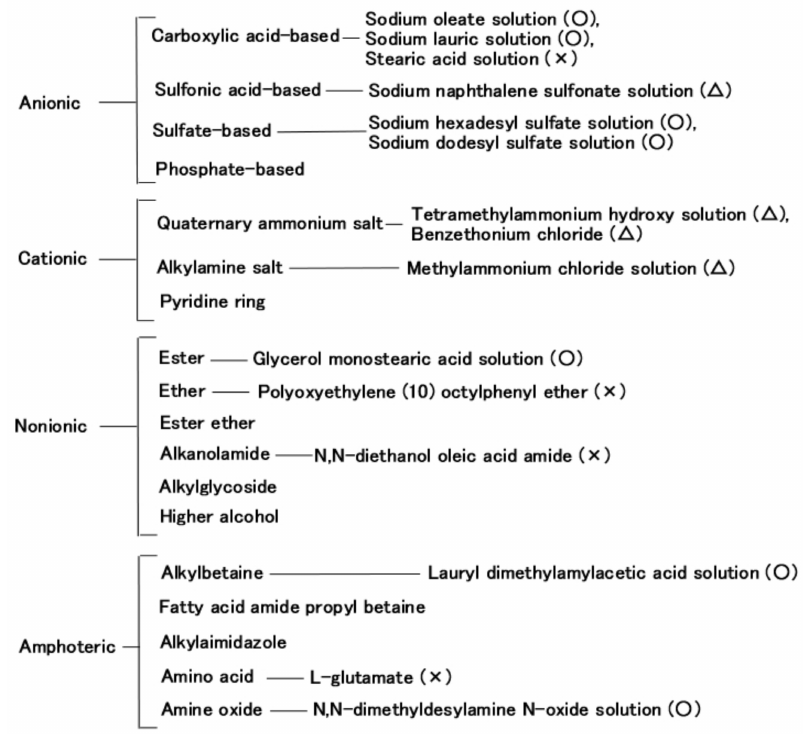
Figure A2. Classification of surfactant.